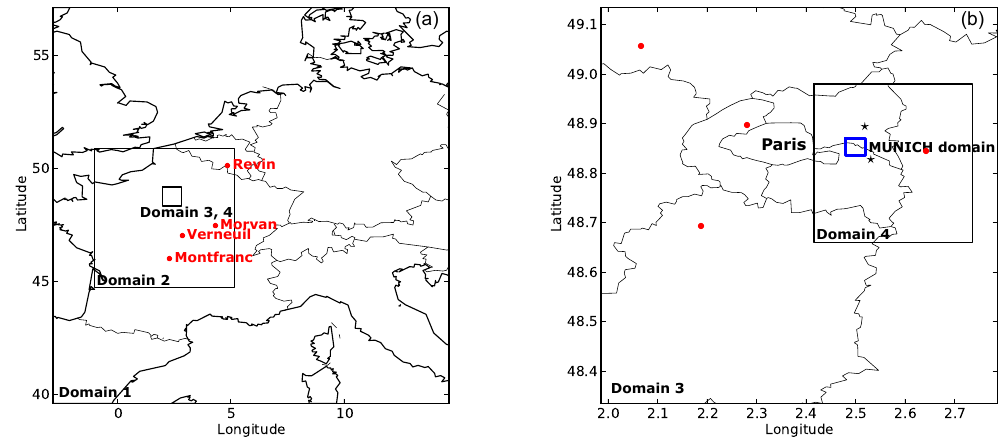
Figure 4. Four simulation domains are simulated from the continental scale to the urban scale. (a) The largest domain 1 covers western Eu- rope. Domain 2 covers northern–central France. The red circles show the locations of the background air monitoring stations. (b) Domains 3 and 4 cover the Île-de-France region and the eastern Paris suburbs. The blue box corresponds to the modeling area in suburban Paris for the MUNICH simulations. The black stars and red circles show the locations of the urban background air monitoring stations. Measured data at the stations with the black stars are used for background concentrations in the MUNICH simulations. SinG is only used for domain